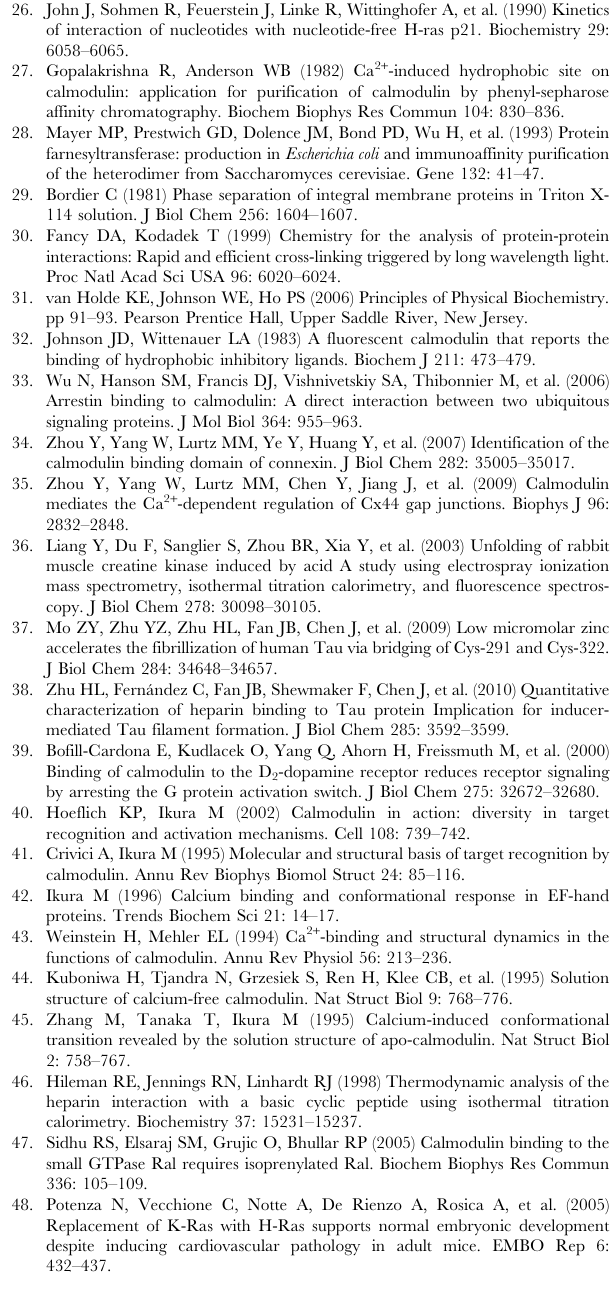
Table S1 Salt concentration dependence of the dissoci- ation constants of K-Ras K-Ras-farn binding to CaM as determined by dansyl-CaM fluorescence titration at 25.0 6 C. The buffer used was 20 mM HEPES buffer (pH 7.4) containing 0.10–1.0 M NaCl, 1 mM CaCl 2 , and 1 mM MgCl 2 . Errors shown are standard errors of the